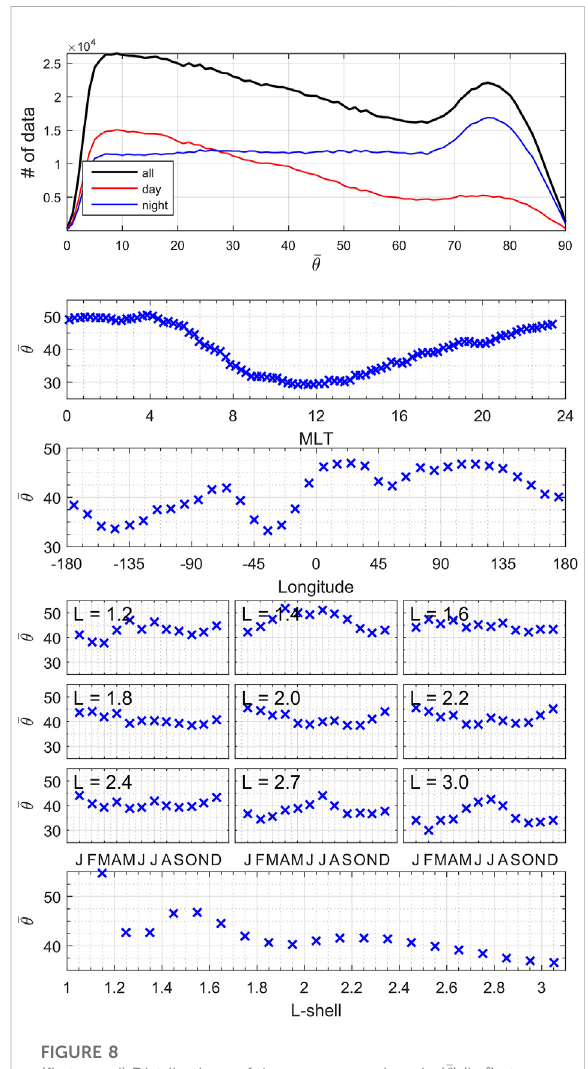
FIGURE 8 ( fi rst panel) Distributions of the wave normal angle ( (cid:1) θ ) (in ° ) at (red) day (6 – 17 MLT), (blue) night (18 – 5 MLT), (black) all times. Wave normal angle is plotted versus (second panel) MLT and (third panel)longitude.Theday/nightdifferencesappearclearlybut not the continental dependence. (fourth panel) Monthly and ( fi fth panel) total average of wave normal angle versus L-shell. No simple seasonal dependence is